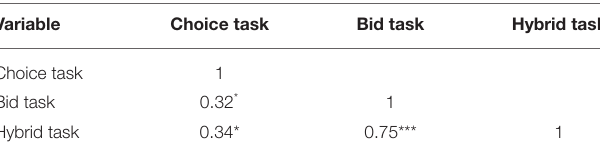
TABLE 2 | The correlation coefficient matrix of the proportions of preferring LL options in the three tasks. Variable Choice task Bid task Hybrid